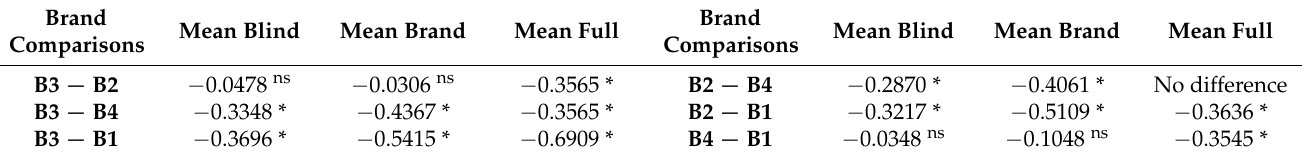
Table 3. Pair comparisons between brands in the three information situations using paired t -test. Brand